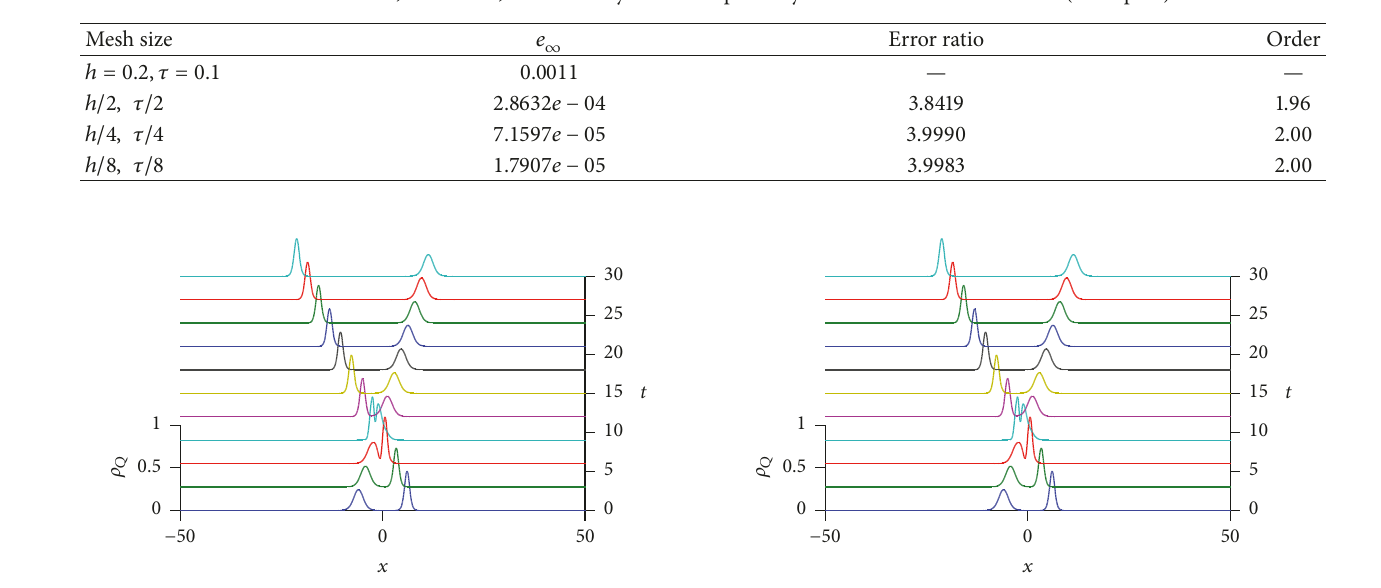
Table 4: The error, error ratio, and accuracy order computed by the CN scheme at time 푡 = 1 (Example 1).